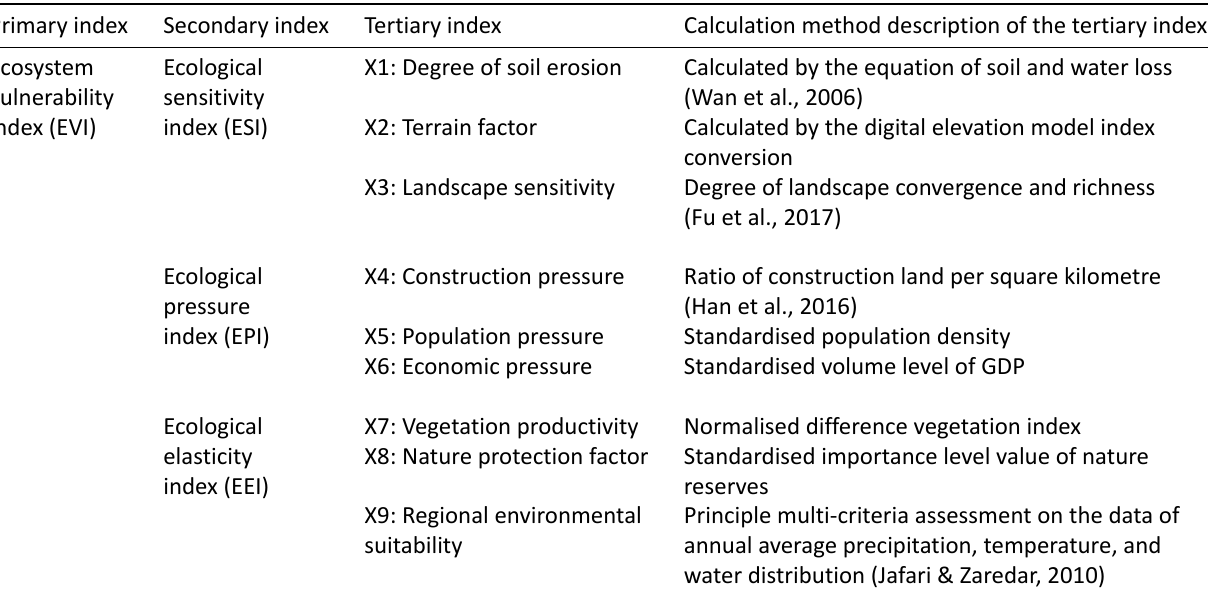
Table 1. Index system for urban ecosystem vulnerability assessment in